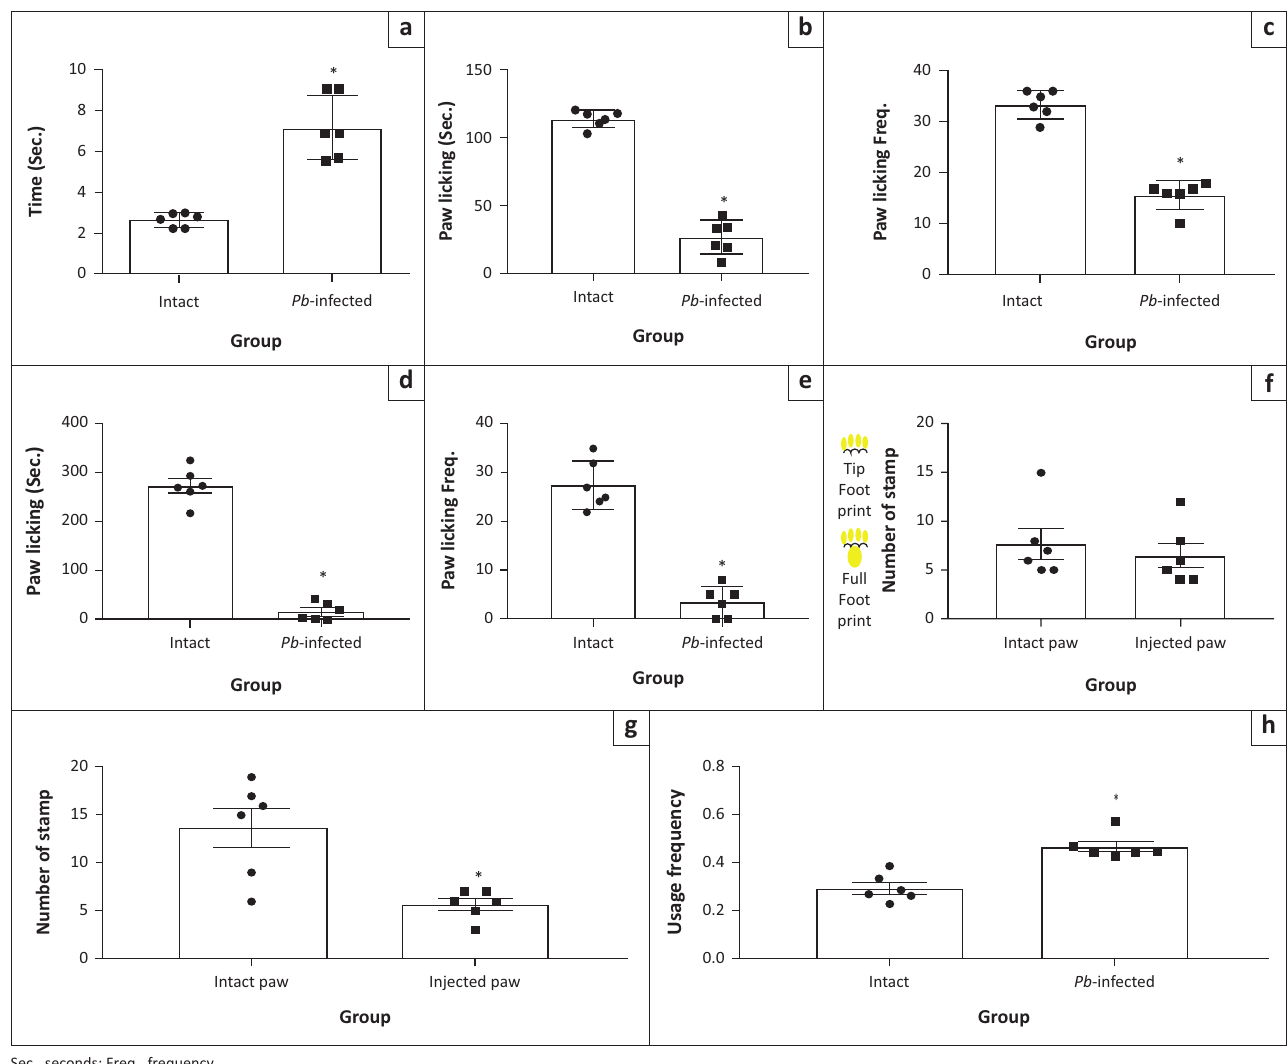
FIGURE 5: Pb - induced malaria ameliorates chronic pain perception. (a) ‘Latent period’: Time taken to make the first paw lick behaviour after formalin injection. (b) Early phase paw-licking (0–5 min) time during formalin test. (c) Frequency of paw licking during the early phase. (d) Late phase paw licking (20–50 min) duration during